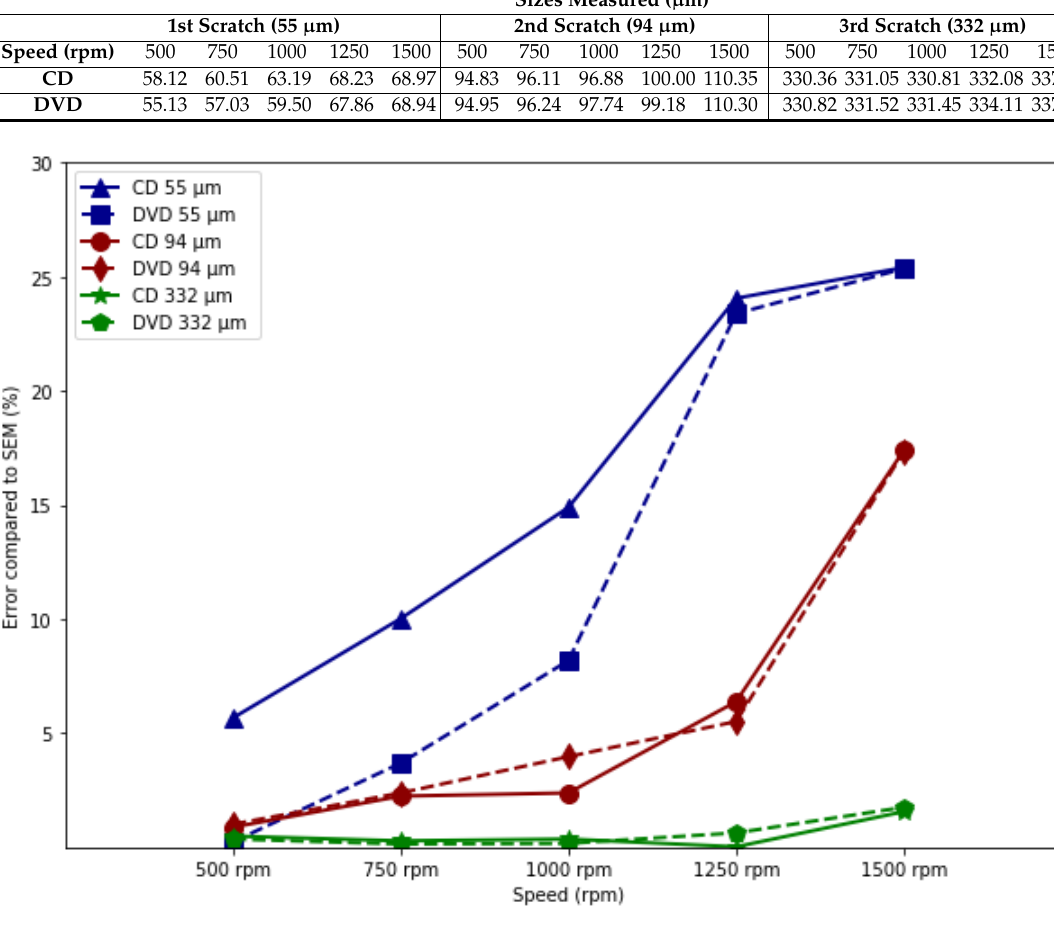
Figure 10. Error compared of three scratches to SEM by CD and DVD pick-up head at speeds of 500 – 1500 rpm.